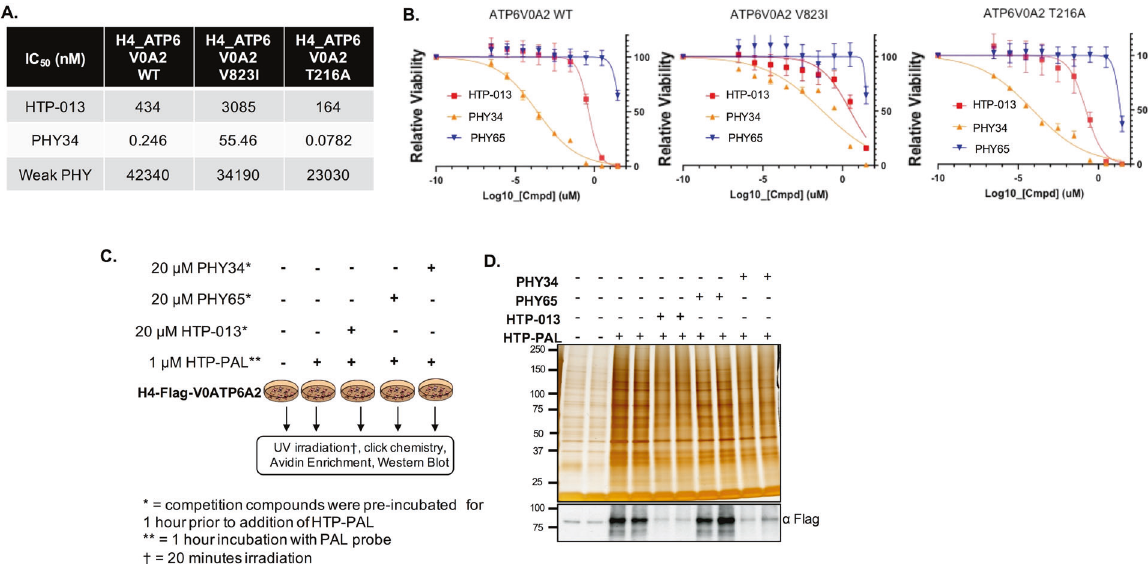
Fig. 7 PHY34 inhibits V-ATPase activity via inhibition of the ATP6V0A2 subunit. A IC 50 values (nM) for PHY34 mediated cytotoxicity in H4 cells expressing WT or mutant forms of the ATP6V0A2 subunit. B IC 50 graphs demonstrating cell viability were obtained by performing CellTiter-Glo assay. C Schematic overview of photoaf fi nity labeling strategy using PHY34, PHY65, HTP-013, and HTP-PAL, a derivative of HTP- 013. D (Top) Silver staining shows results of photoaf fi nity labeling pulldown. (Bottom) Immunoblot using Anti-Flag antibody to demonstrate binding between compounds and